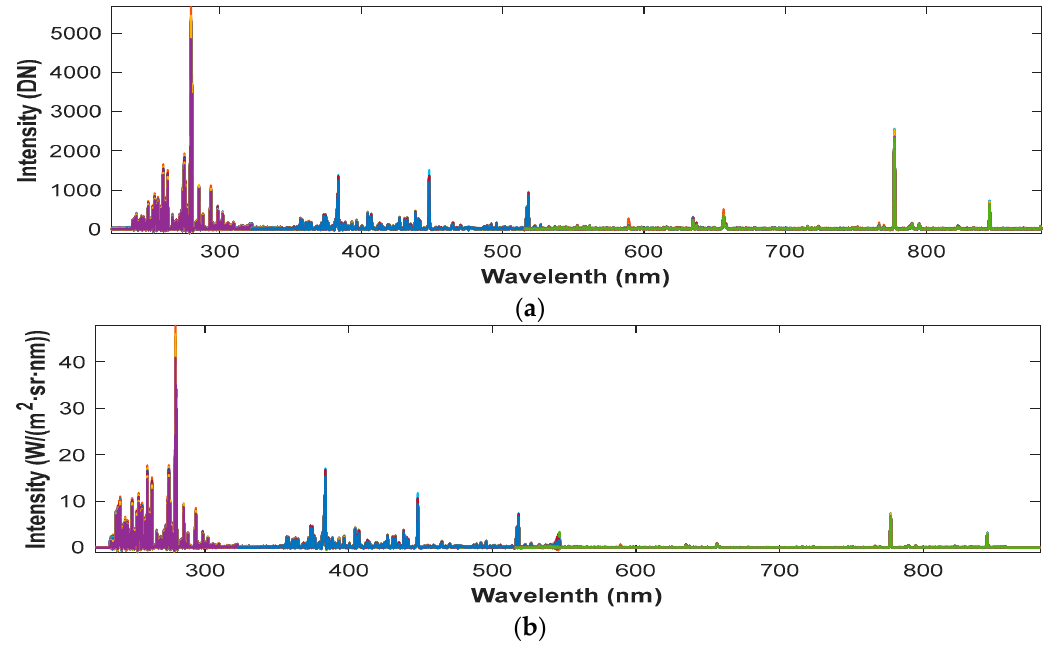
Figure 5. Wavelength and radiation calibration of 58 LIBS spectra for Sample-A06: ( a ) wavelength calibration; ( b ) radiation calibration.